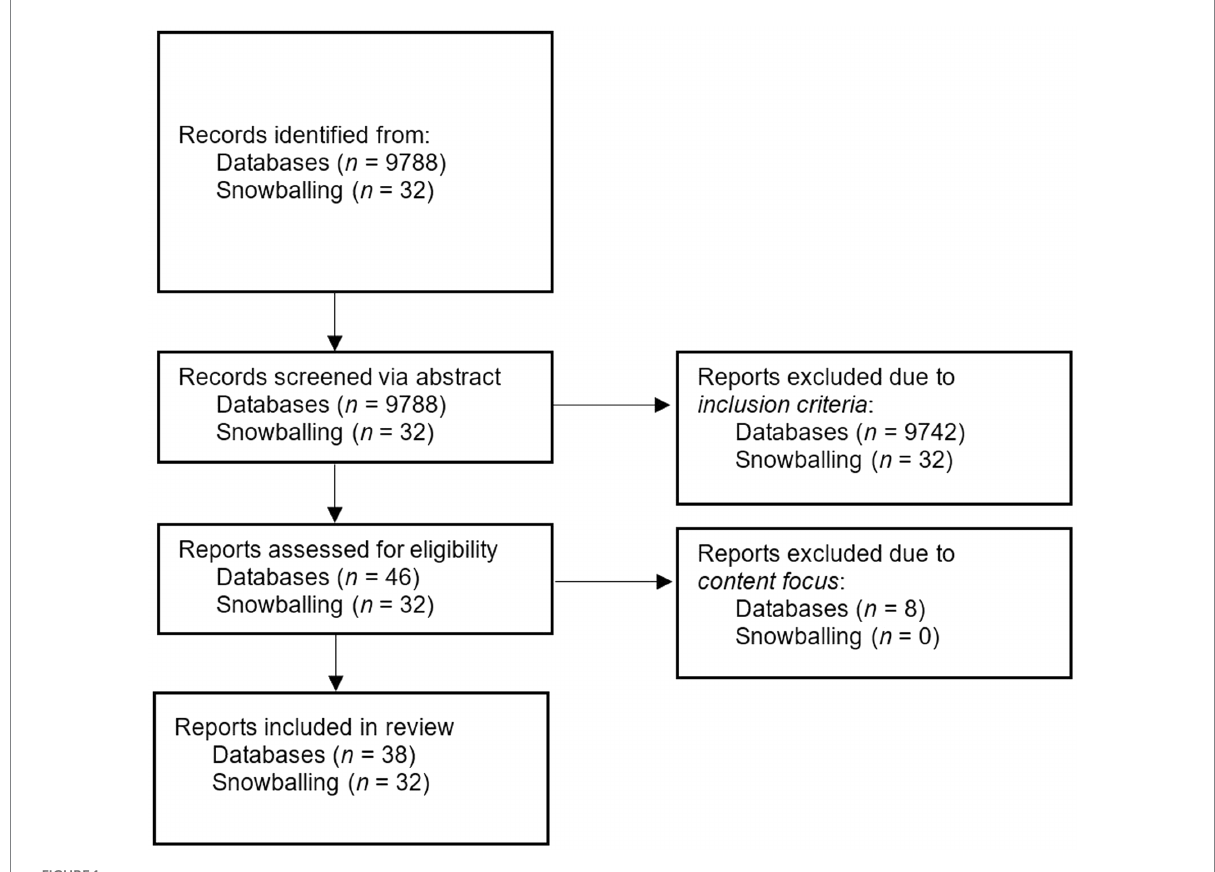
FIGURE 1 Identification of publications via databases and snowballing.